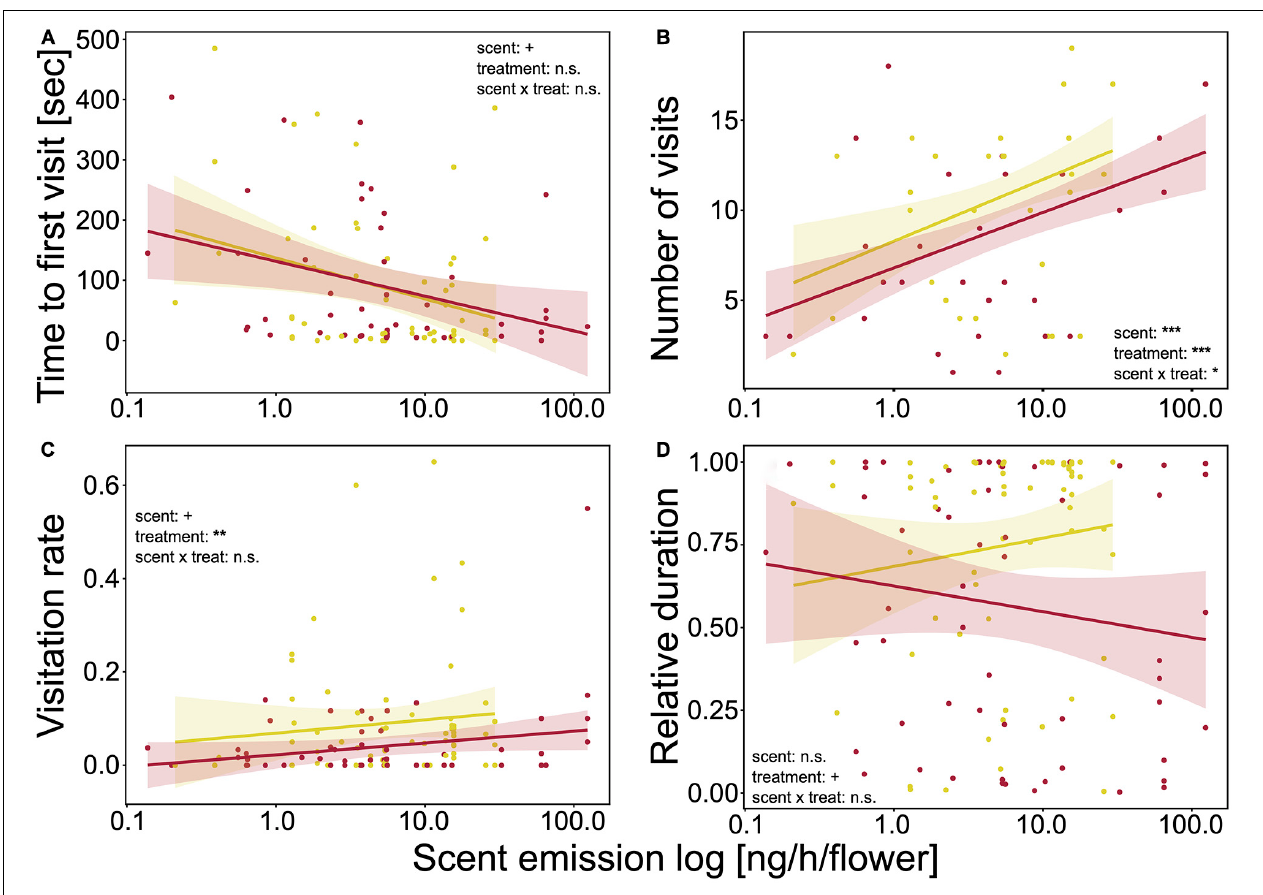
FIGURE 3 | Behaviors of bumblebees in correlation with total scent emission [ng/h/flower] (logarithmic scale). (A) Time to first plant visit [sec] (approach or landing); (B) number of visits (approaches plus landings); (C) flower visitation rate per landing [min]; and (D) duration of landings, relative to active time of bumblebees. Colored lines show trend lines for significant correlations of behavior and plant trait; colored areas show confidence interval. Correlations were measured using linear mixed-effect models. Significance levels are given as asterisks: *** p < 0.001; ** p < 0.01;* p < 0.05; + p < 0.10; and n.s.,